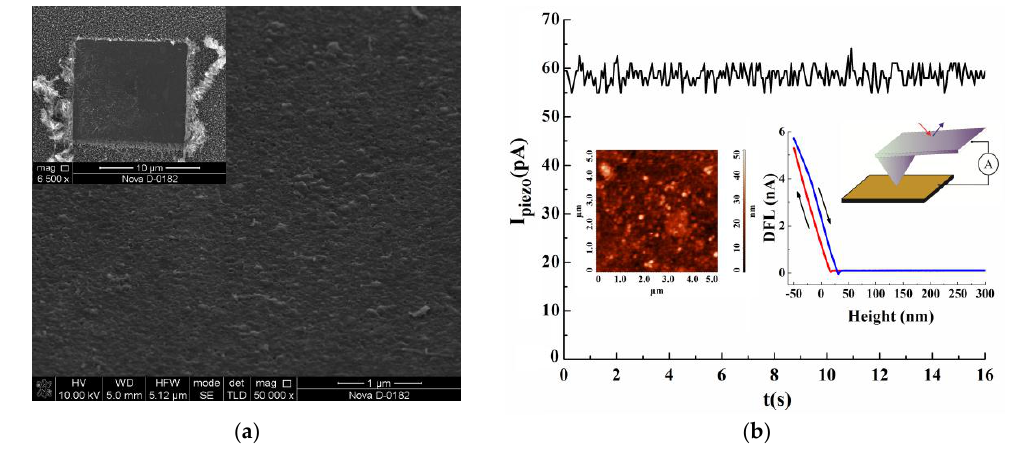
Figure 3. The results of the piezoelectric response of the mechanically purified substrate: ( a ) a SEM image of the purified area. The inset is a SEM image of the 20 × 20 μm 2 area of the array and was scanned in the AFM force lithography mode; ( b ) the current-time correlation of the substrate straining in the AFM force spectroscopy mode. The inset shows an AFM image of the research area, schematic image of the measurement process, and the results of AFM force